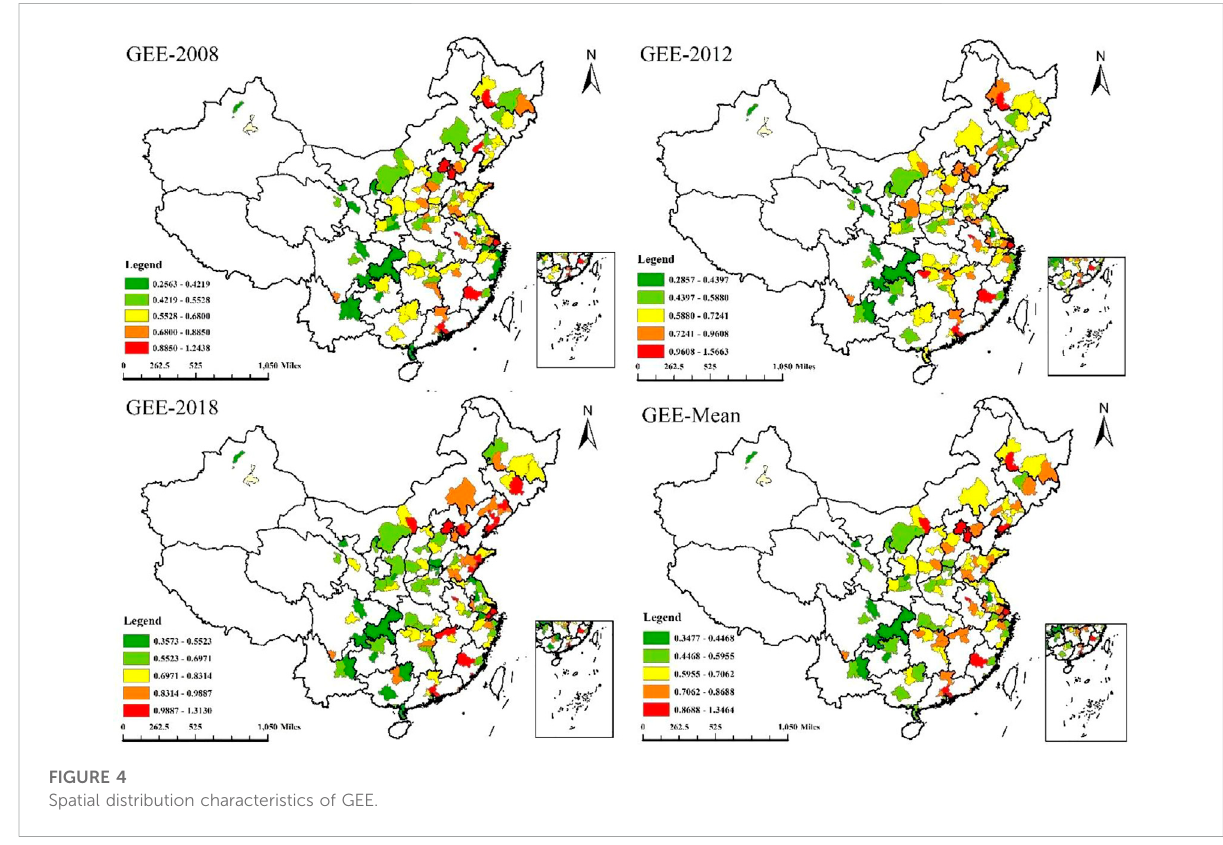
FIGURE 4 Spatial distribution characteristics of GEE.